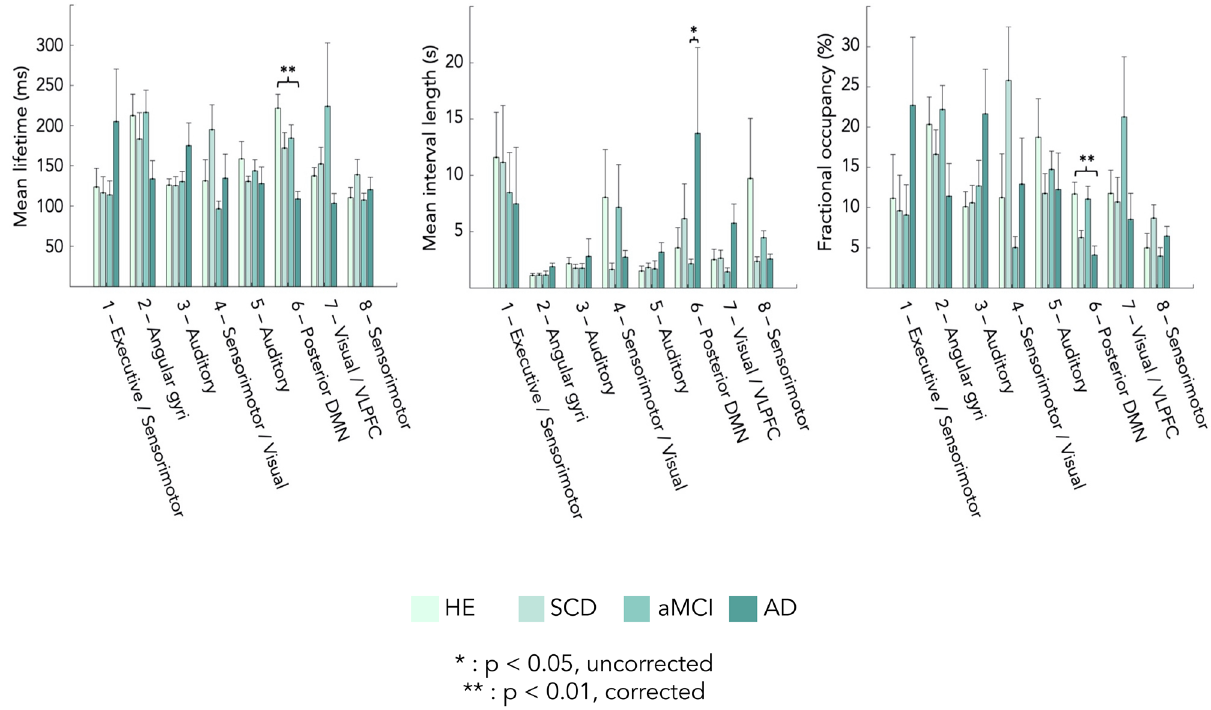
Figure 2. Group differences in state temporal parameters. From left to right: mean lifetime (MLT), mean interval length (MIL) and fractional occupancy (FO). HE healthy elders, SCD subjective cognitive decline, aMCI amnestic-mild cognitive impairment, AD Alzheimer’s disease with dementia, DMN default-mode network, VLPFC ventrolateral prefrontal cortex. * p < 0.05, uncorrected; ** p < 0.01, Bonferroni corrected for 7 independent states. Standard error is represented above each